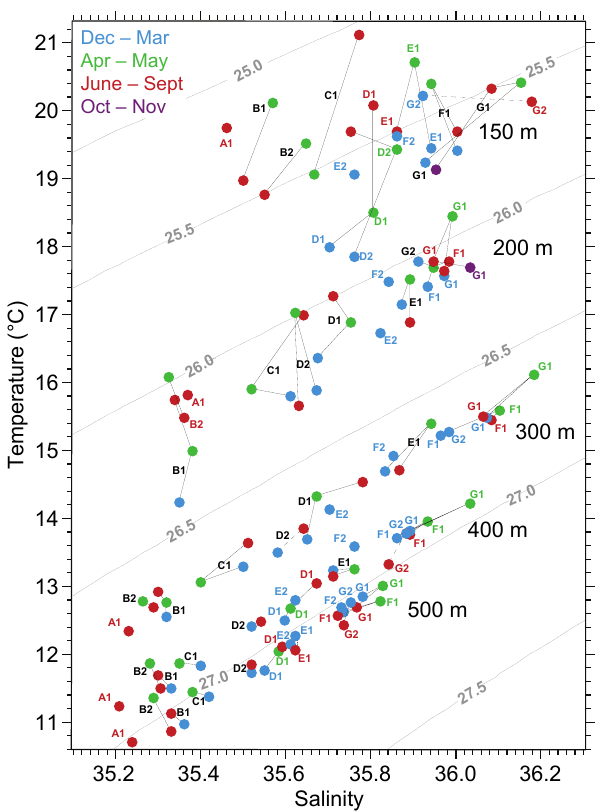
Fig. 3. T – S diagram for medians with ≥ 4 pairs per season of tem- perature and salinity in the boxes of our database (Table